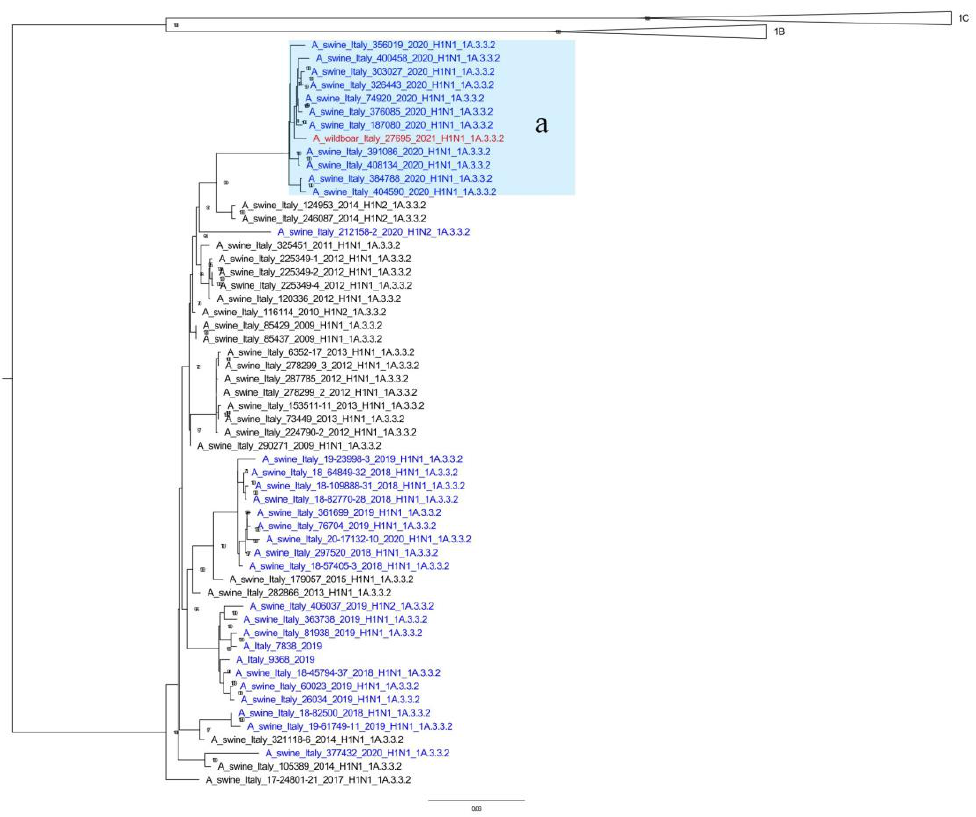
Figure 3. ML phylogenetic tree showing the wild boar A/wild_boar/27695/2021 swIAV detected in this work together with 55 HA-H1A (1A.3.3.2) Italian sequences (1575 nucleotides) of strains recently analyzed. The tree was inferred with 507 recently-described Italian sequences [29,38] retrieved from GenBank and collected in the years 2009–2020. The recently-described [29] sub-cluster a was highlighted in pale blue. The detected wild boar swIAV is written in red. Strains detected since 2018 are in blue, and older strains are in black. Bootstrap values under 70% are not shown; scale bar represents number of nucleotide substitutions per nucleotide site.